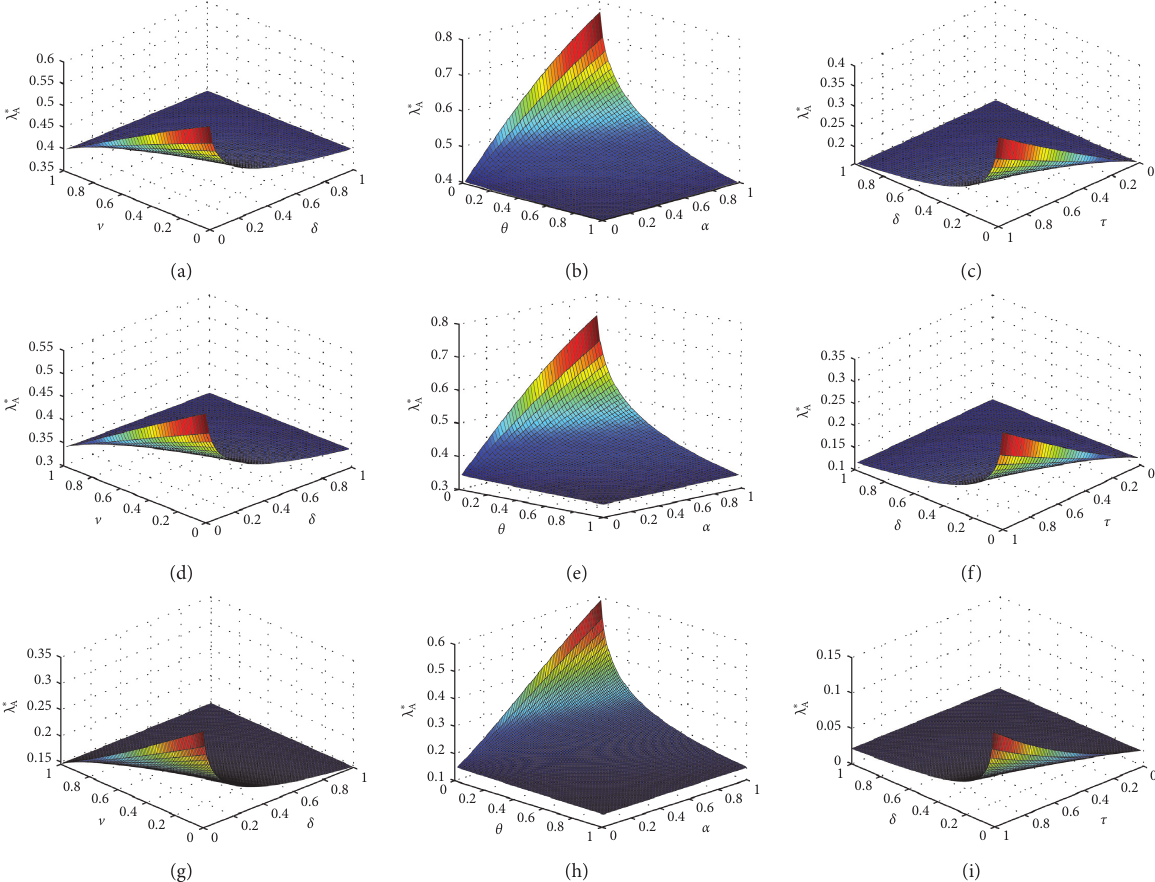
Figure 3: Variation law of the counterparty’s credit risk contagion rate threshold under different corporate credit-related network